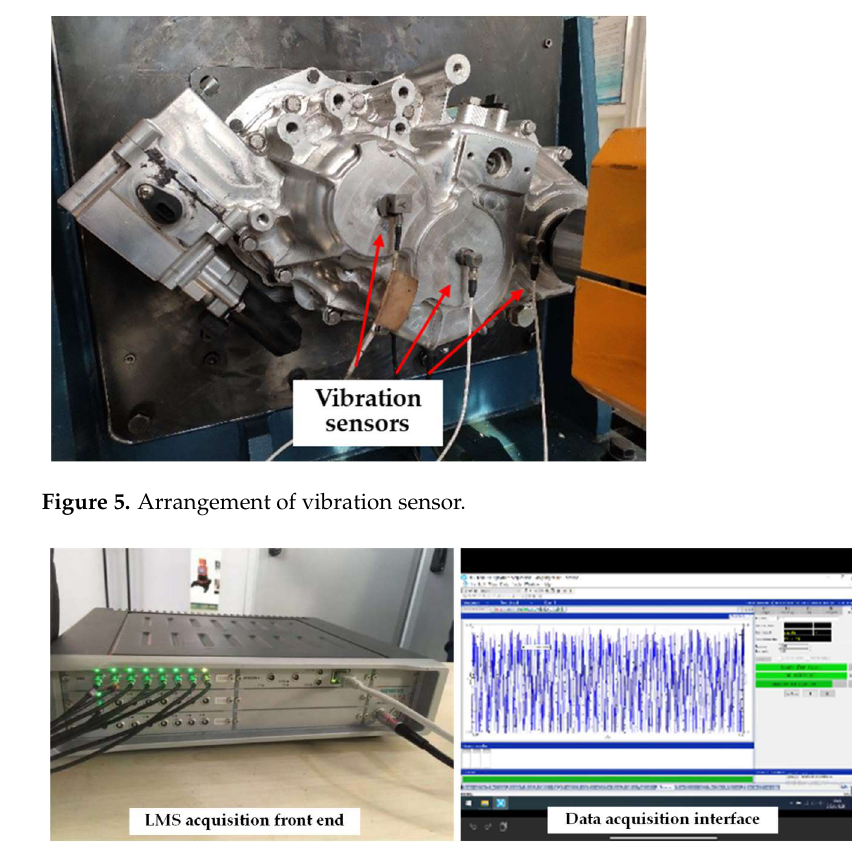
Figure 6. Acceleration sensor LMS acquisition front end and real-time data feedback. Table 2. Description of experimental data set.